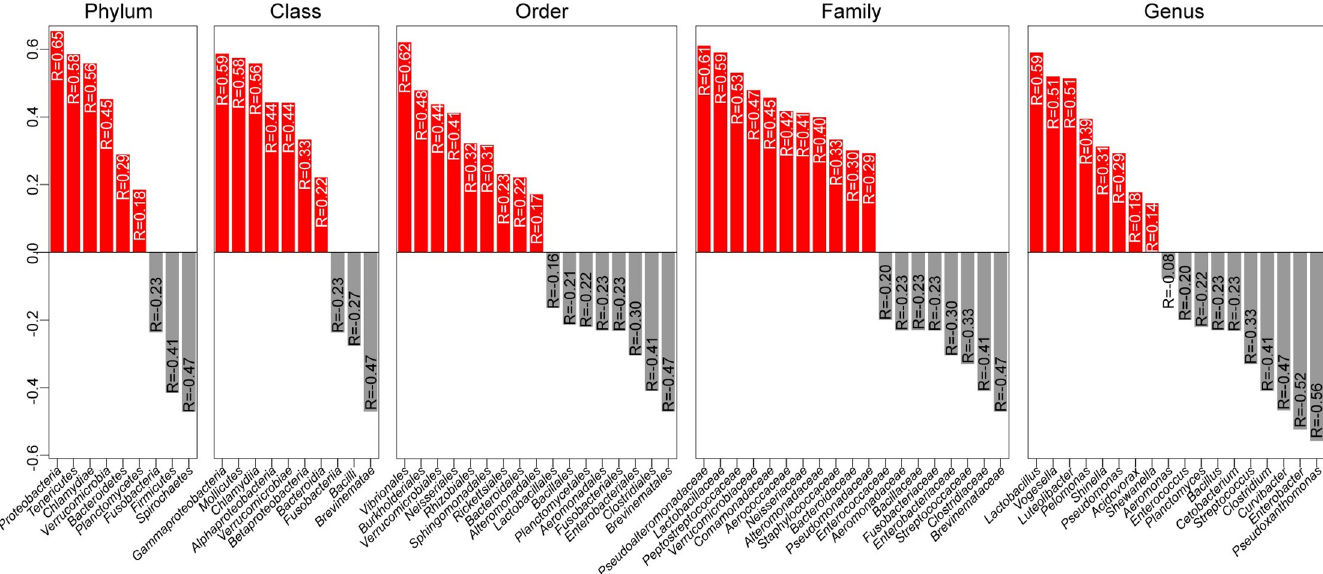
Fig 2. Spearman correlation analysis was performed to measure the associations between the ABW and the intestinal taxa of Cyprinus carpio . The correlation values range from –1 to +1 and indicate the level of consistency of the positive ( � 0; red) and negative ( < 0; grey) correlations. The correlations were calculated at five taxonomic levels: phylum, class, order, family, and